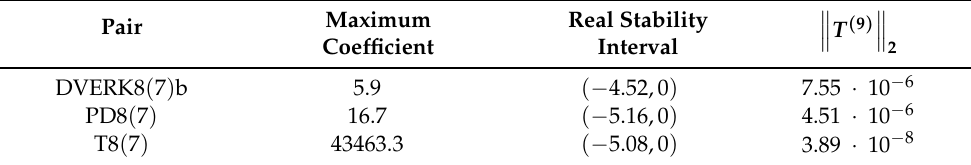
Table 2. Basic characteristics of the RK pairs considered. Pair